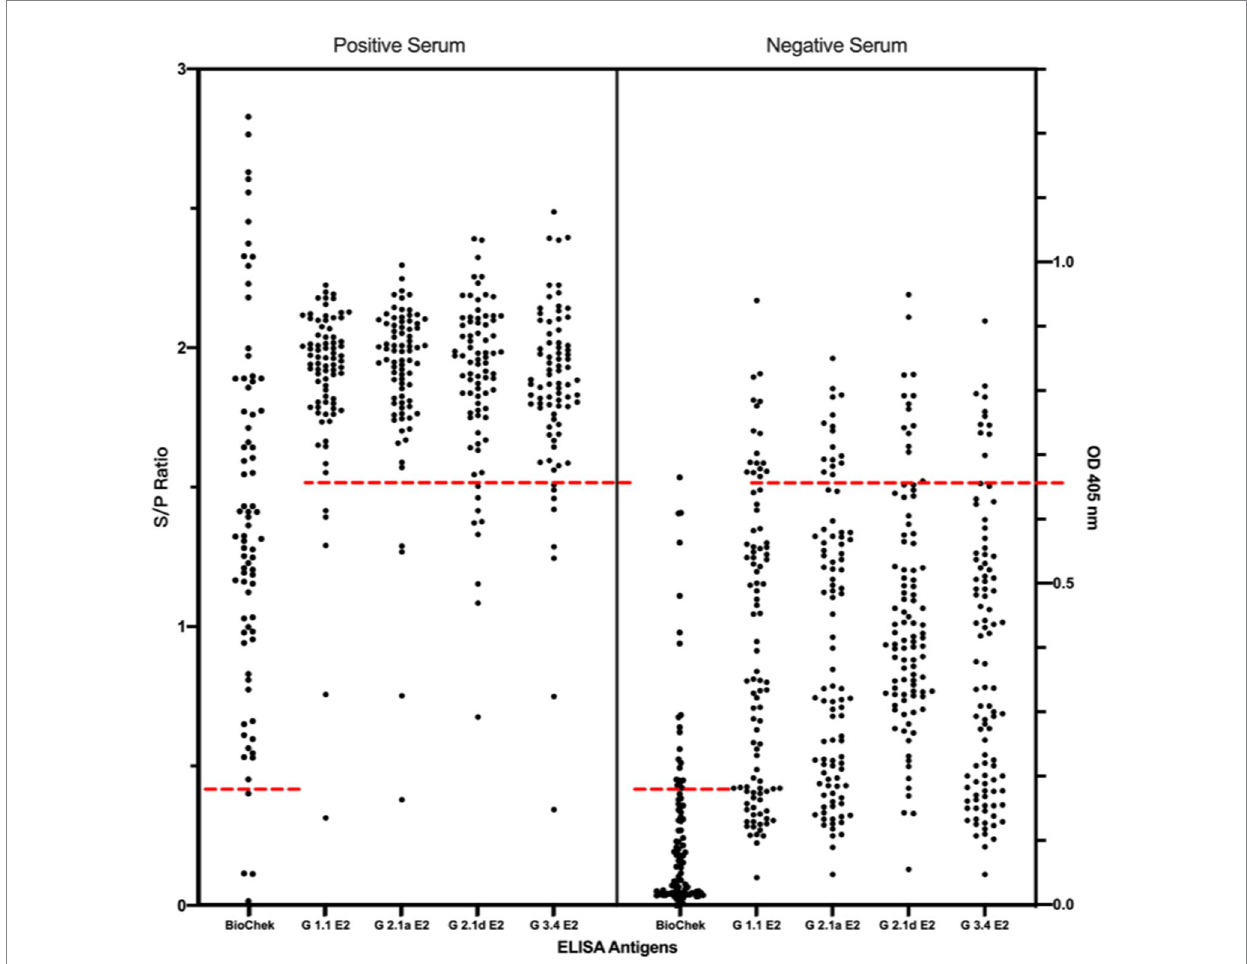
FIGURE 3 Comparison of cross-reactivities of serums derived from pigs with/without LPC vaccine-immunization among the commercial CSFV E2 ELISA and different four different in-house E2 glycoproteins-based ELISA. Results of the commercial CSFV E2 ELISA and in-house E2-based ELISAs are represented as in S/P ratio and OD 405, respectively. Black round dots on the right column are IFA-confirmed negative serums and dots on the left column are the IFA-confirmed serums. Cut-off values are calculated according to the manufacture’s guideline or the mean value of the negative samples plus two standard deviations (mean + 2SD) for in-house ELISA presented as red dotted lines.